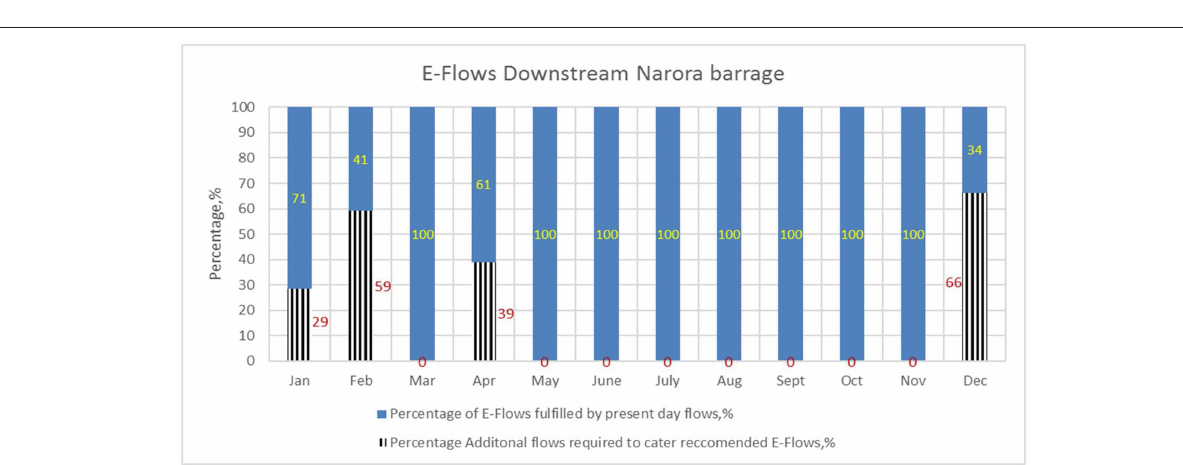
India) is working with over 2,000 farmers in 40 villages of 8 districts of Uttar Pradesh in Ganga Basin. This work